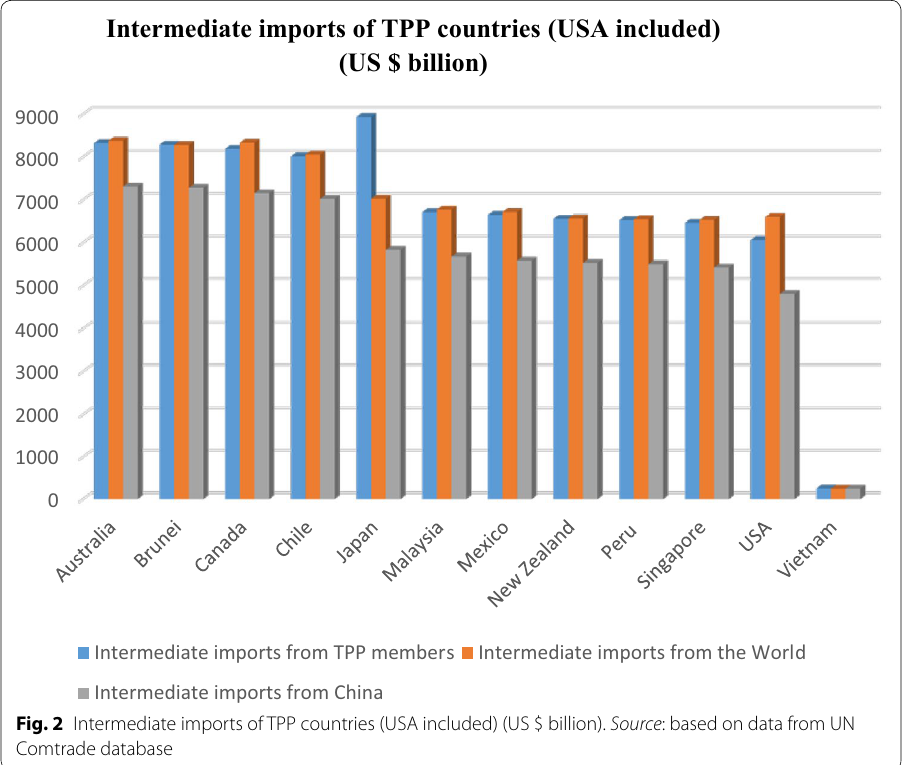
Fig. 2 Intermediate imports of TPP countries (USA included) (US $ billion). Source : based on data from